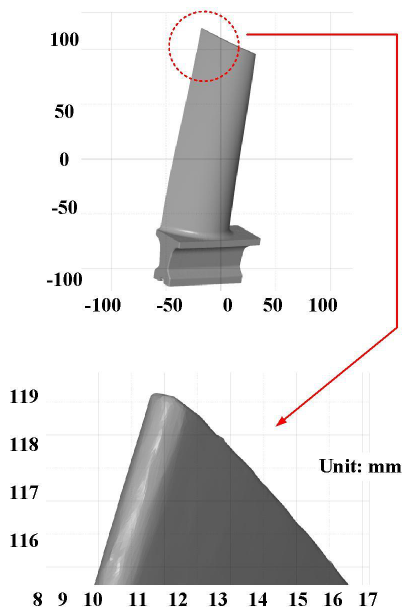
Figure 4. Measurement results of the as-cast turbine blade that was sprayed with a mixture of TiO 2 powder and ethanol before optical measurements. Materials 2022 , 15 , 6139